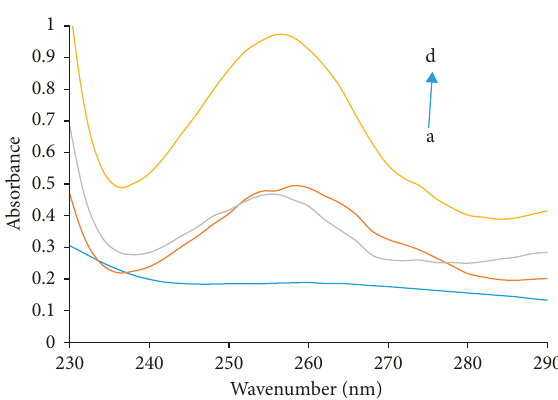
Figure 5: UV-visible absorption spectrum of aqueous solution of pyridoxine added to adenine at pH 7.0 with constant concentration 3 M). The lowest to highest spectrum corre- of adenine (1.0 10 × 5 M, (c) 4.0 10 5 M, and (d) sponds with (a) 0.0 M, (b) 3.0 10 − × × 5 M pyridoxine. 5.0 10 − × −